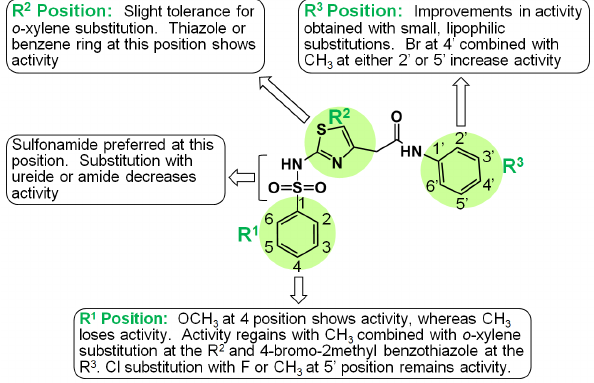
Figure 8. Preliminary Structure and Activity Relationship (SAR) map of compound 12. A total of 53 similarly structured compounds were analyzed to generate this map (See Figure 7 for structures and IC 50 values for 13 compounds).